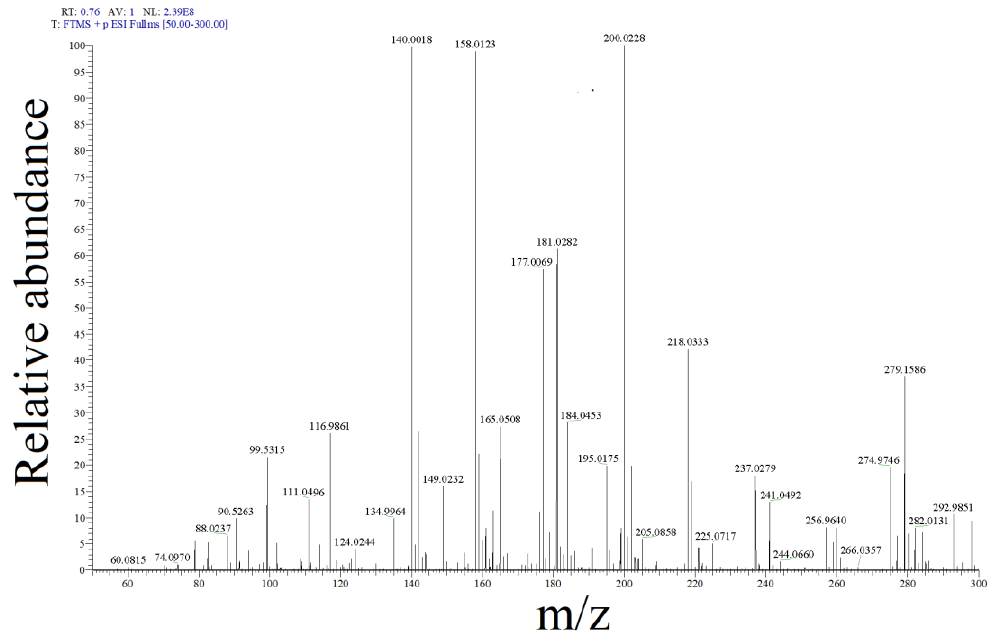
Figure 2. Q-Exactive spectrum degradation products of SMX.